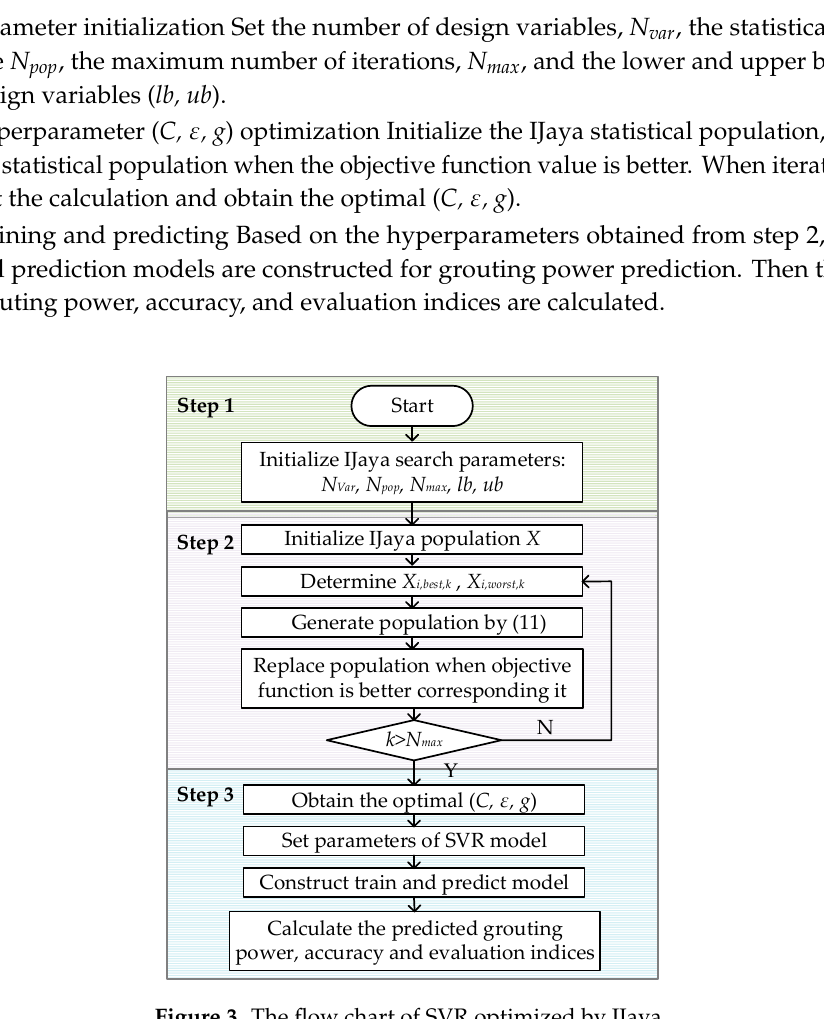
Table 1. Statistical descriptions of the grouting power series.